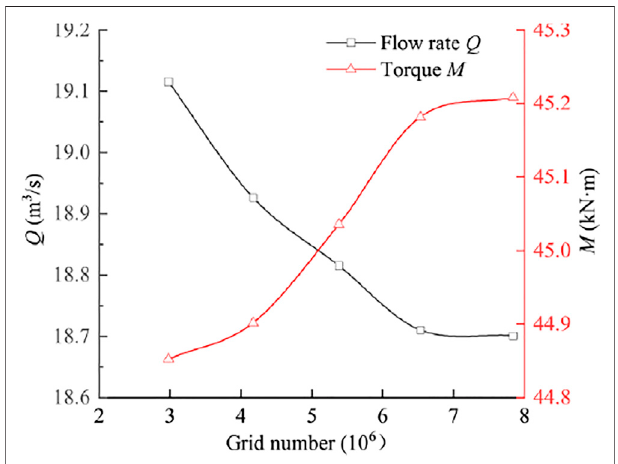
FIGURE 3 | Grid independency